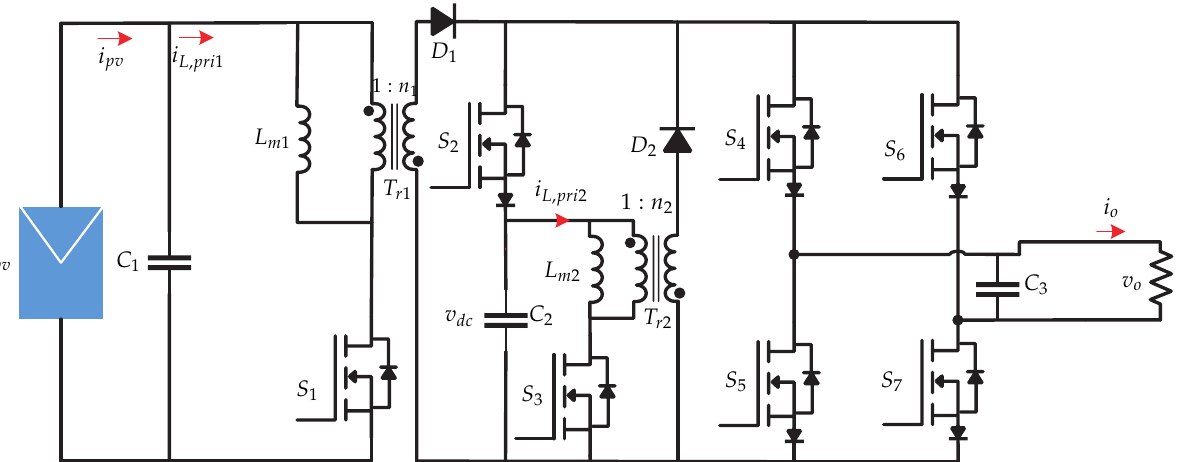
Figure 24. Microinverter’s topology proposed in [63].